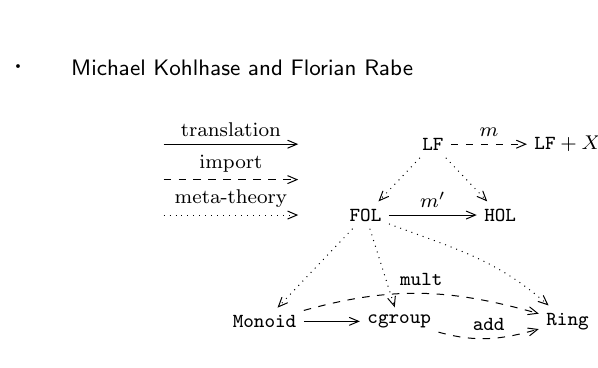
Fig. 2. Meta-Theories and Theory Morphisms in OMDoc /